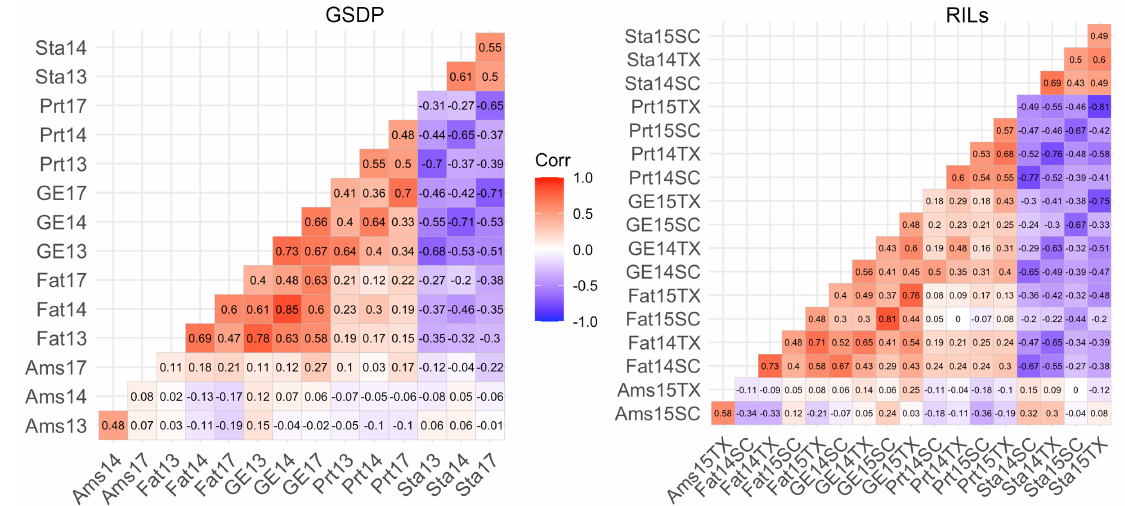
Figure 1. Correlation between traits across year and location combination for the two populations. Ams: amylose, GE: gross energy, Prt: protein, Sta: starch, SC: South Carolina, TX: Texas, and numbers in x and y-axes represent the year.